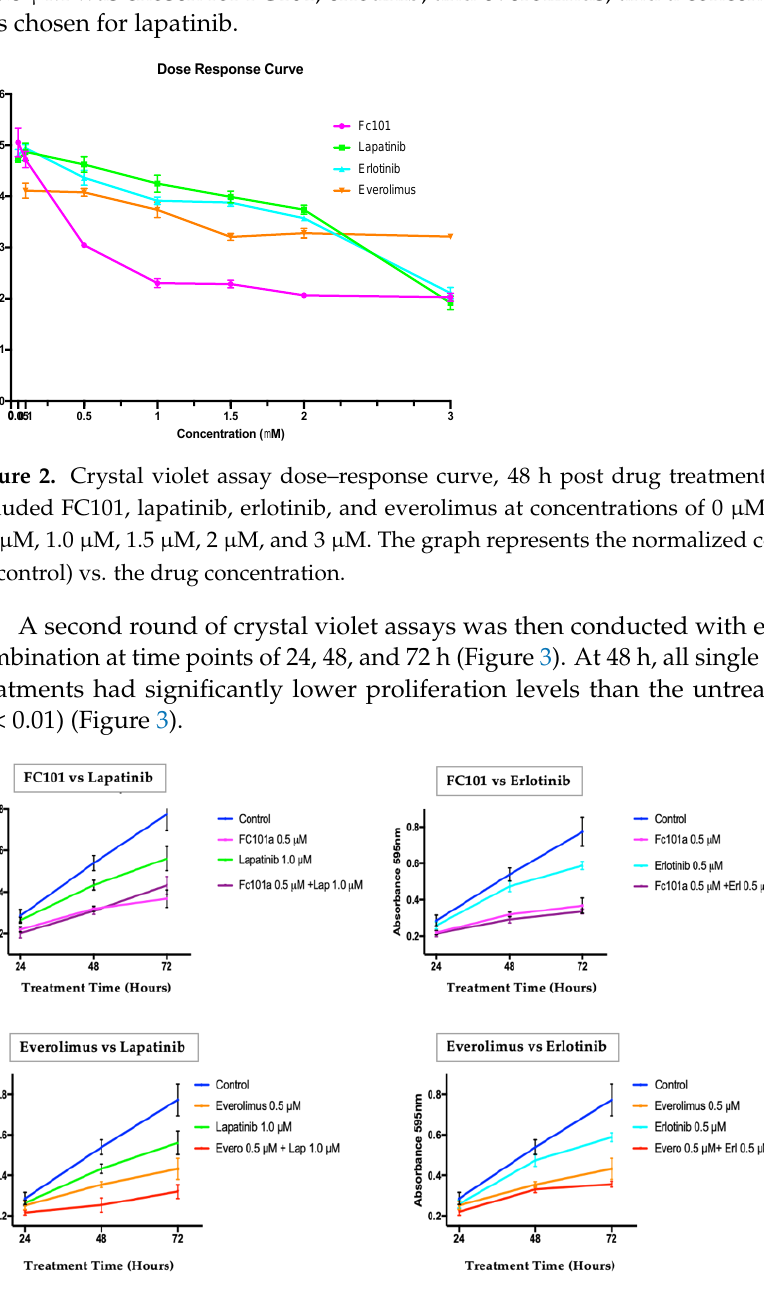
Figure 3. Crystal violet staining assay time response curve. Treatment concentrations included FC101 (0.5 μM), lapatinib (1.0 μM), erlotinib (0.5 μM), everolimus (0.5 μM), and combinations of FC101 or everolimus with lapatinib or erlotinib. The graph represents normalized A 595 (% control) vs. time course treatments at 24, 48, and 72 h.